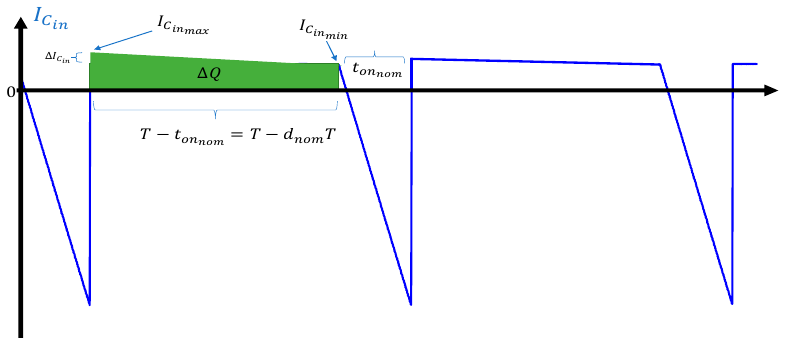
Figure 13. Simulated input capacitor current.